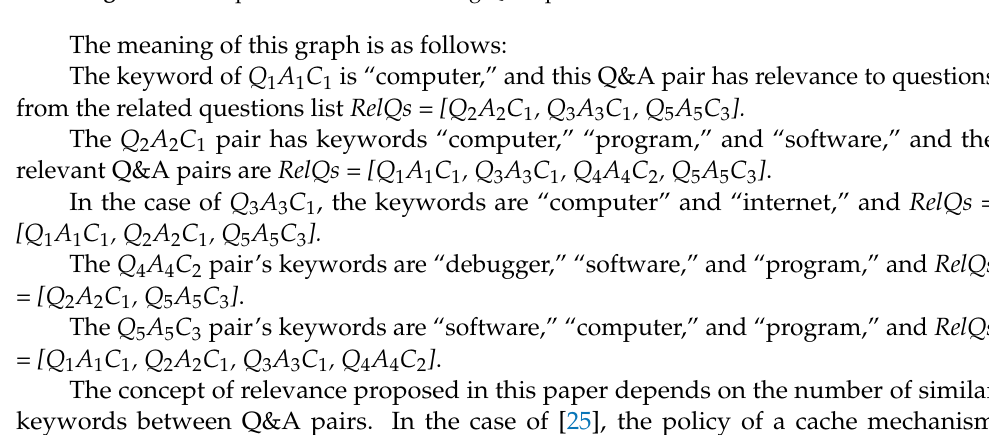
Figure 3. Example of relevancies among Q&A